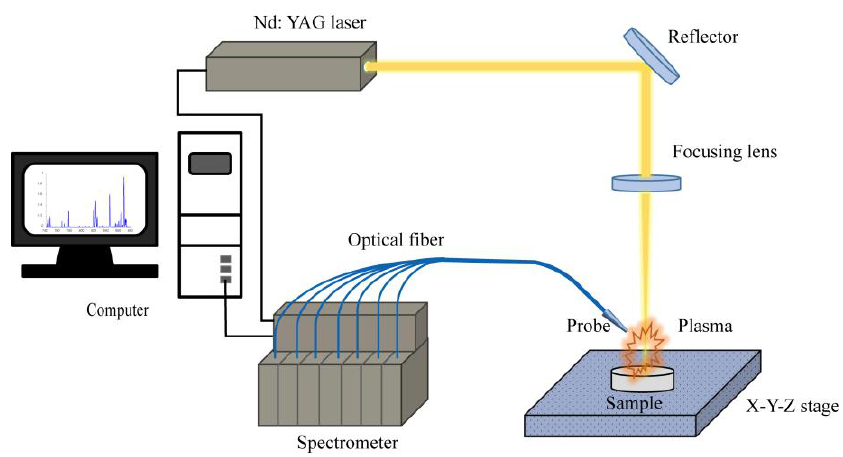
Figure 1. Schematic diagram of laser-induced breakdown spectroscopy (LIBS) experimental setup for gelatin samples.